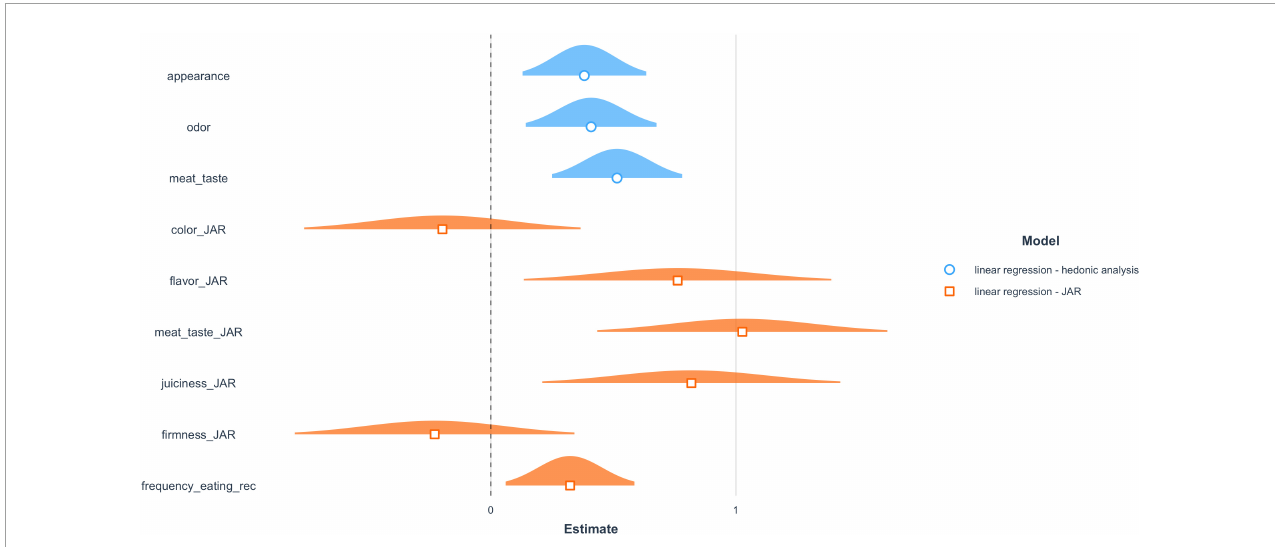
FIGURE5 Regression